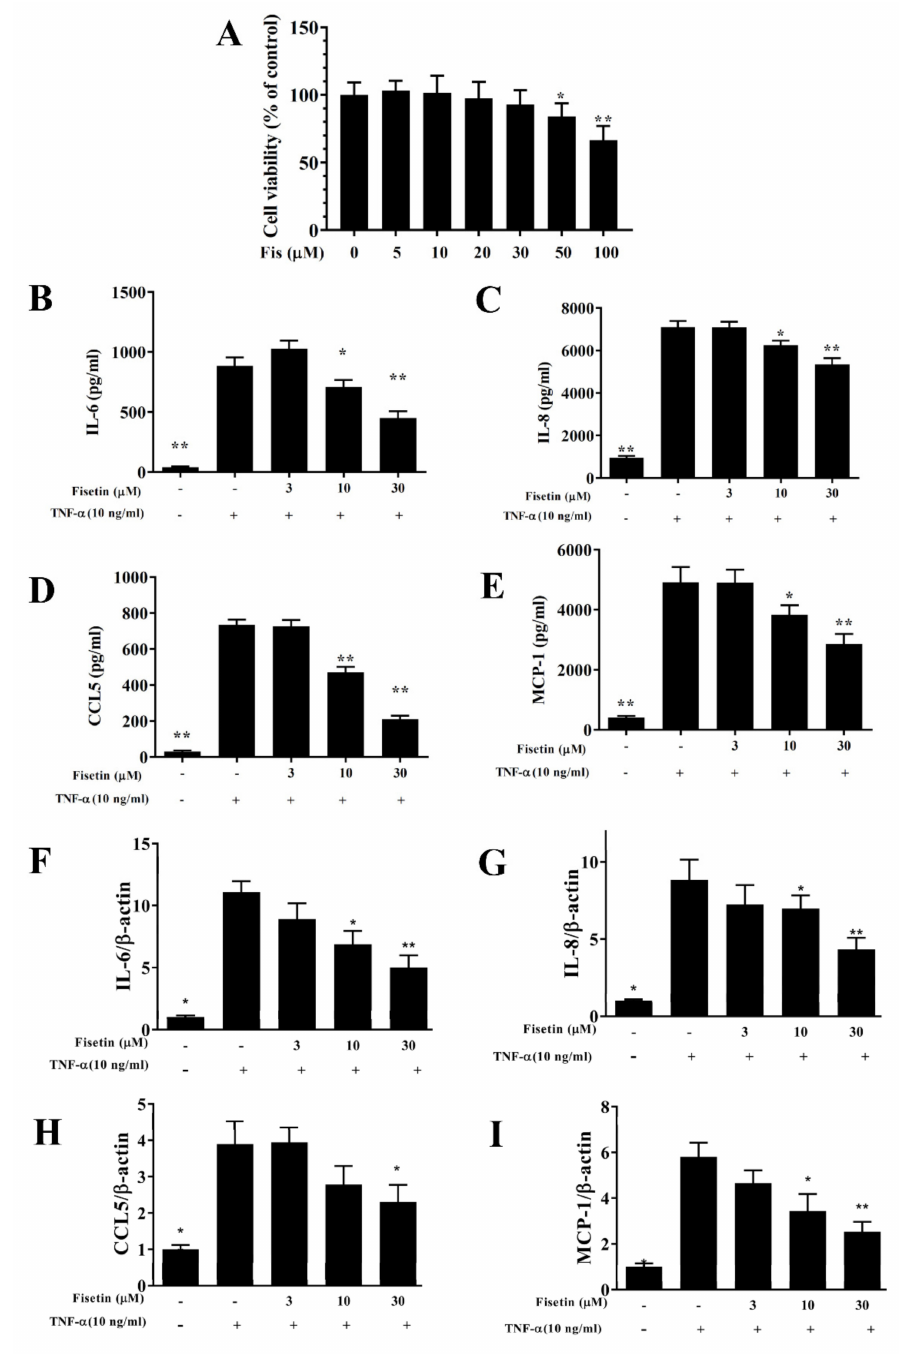
Figure 1. The inflammatory response was inhibited by treatment with fisetin in TNF- α -induced BEAS-2B cells. ( A ) Cell viability detected by CCK-8 reagent, and data expressed as mean ± SEM. * p < 0.05, ** p < 0.01, compared to normal BEAS-2B cells. ( B ) IL-6, ( C ) IL-8, ( D ) CCL5, and ( E ) MCP-1 expressions detected by ELISA ( n = 12 per group). ( F ) The gene expression of IL-6, ( G ) IL-8, ( H ) CCL5, and ( I ) MCP-1 determined using real-time PCR. The fold expression presented relative to β -actin ( n = 8 per group). The data are presented as mean ± SEM of three independent experiments. * p < 0.05, ** p < 0.01, compared to the TNF- α -stimulated BEAS-2B cell